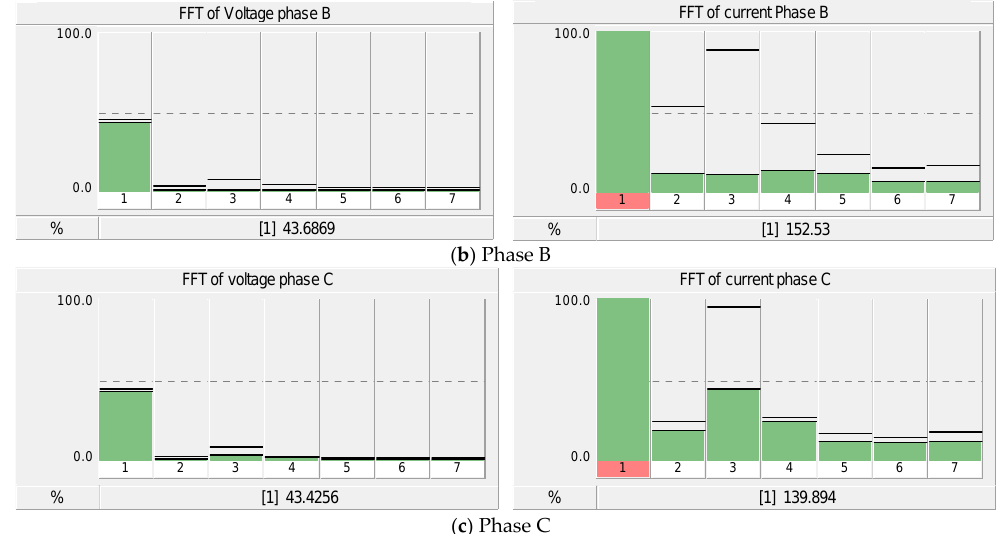
Figure 28. The frequency spectrums of the phase voltage and current at the LV side (0.4 kV) transformer 500 kVA when the BRKB close circuit is at 0.8 s.